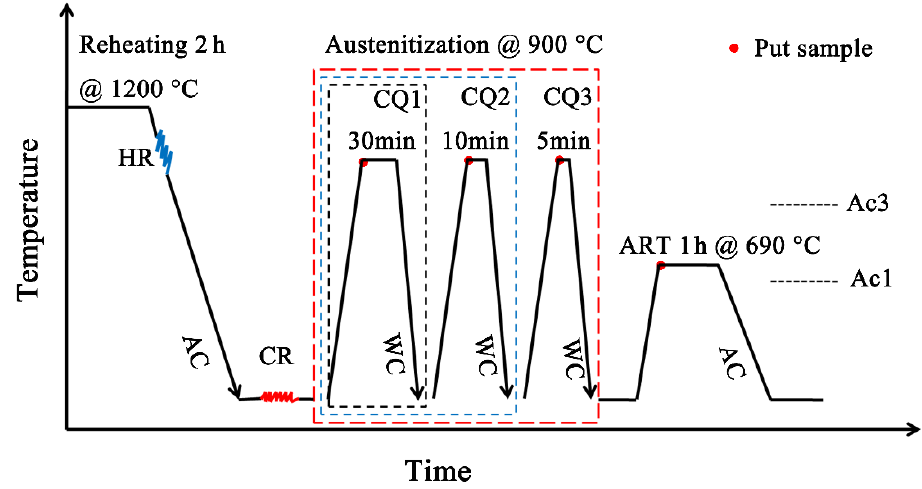
Figure 1. CQ-ART heat treatment process schematic diagram of cold-rolling experimental steel.